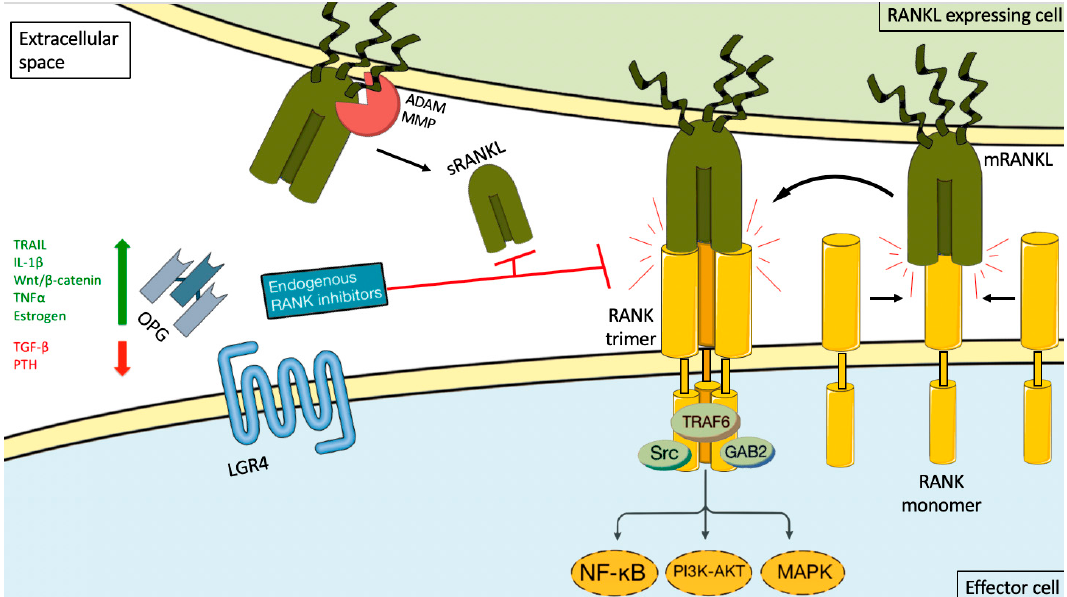
Figure 1. RANKL/RANK signaling and its endogenous inhibition. Binding between RANKL and RANK induces receptor trimerization, which triggers recruitment of TNF receptor associated (TRAF) adaptor proteins and activation of downstream signaling pathways (such as NF- κ B, PI3K-AKT, and the MAP kinase cascade). This activity can be induced by either membrane-bound RANKL (mRANKL) or soluble RANKL (sRANKL). sRANKL is derived from the membrane-bound form through alternative splicing or proteolytic cleavage (for example, by matrix metalloproteinase (MMP) or disintegrin and metalloproteinase (ADAM) family members. RANK itself lacks kinase activity, and its signaling is initially mediated by adaptor molecules, such as TRAF proteins (including TRAF6), GRB-associated-binding protein 2 (GAB2), and sarcoma proto-oncogene tyrosine-kinase (SRC). The signaling cascade is controlled by a decoy receptor called osteoprotegerin (OPG) and leucine-rich repeat-containing G protein-coupled receptor 4 (LGR4). OPG expression can be upregulated by several factors such as TRAIL, IL-1 β , Wnt/ β catenin signaling, TNF α , and estrogen, and down regulated by TGF- β and PTH. The endogenous inhibitors bind both the soluble and membrane-bound RANKL forms, thereby preventing it from interacting with RANK. The green arrow stand for upregulation, the red arrow for inhibition and the black arrows for possible interactions and the curved black arrow for the result of interaction.